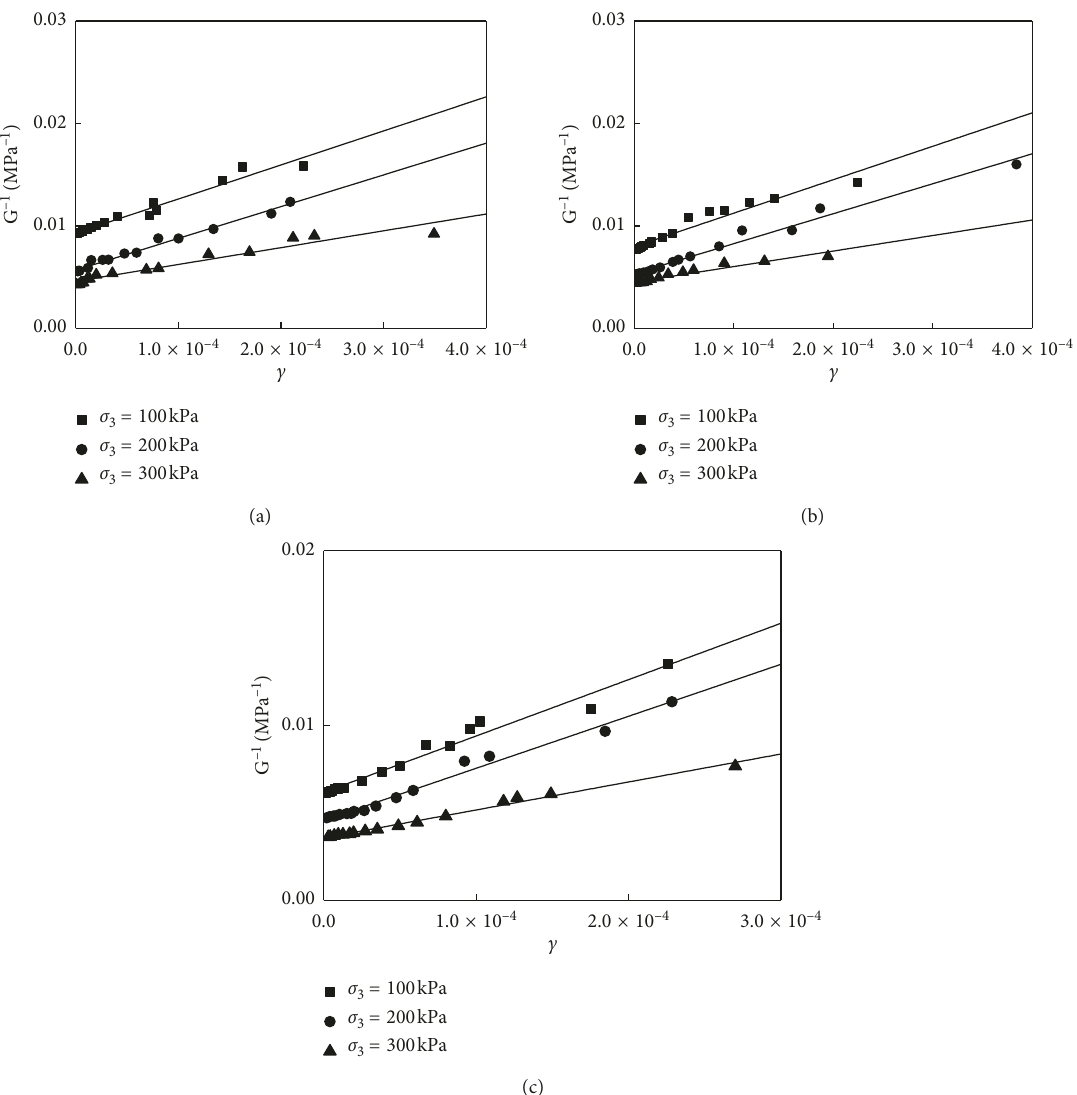
Figure 9: Fitted lines of G − 1 and c under different relative densities: (a) D